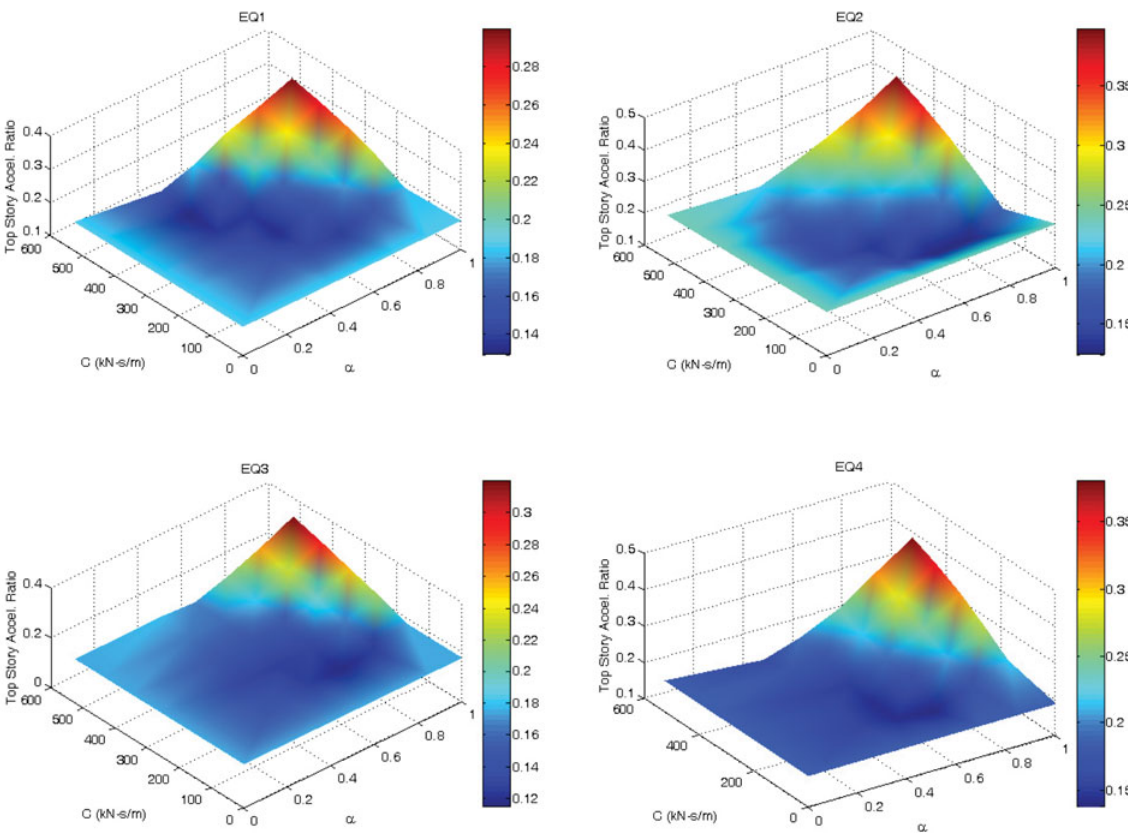
Fig. 6. Top Story Acceleration Ratio (TSAR)